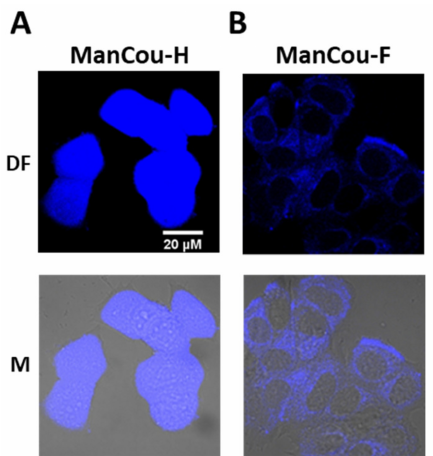
Figure 2. Confocal fluorescence images of MCF7 cells treated with 25 µ M of GLUT5 activity re- porter ManCou-H ( A ) and ManCou-F ( B ). Fluorescence images were obtained using an Olympus FluoView TM FV1000 confocal microscope and 60 × objective. Images were acquired using a DAPI filter (exc/em: 405 nm/461 nm), DF—dark field, and M—fluorescence overlay images with the bright field. The scale bar for all images is 20 µ